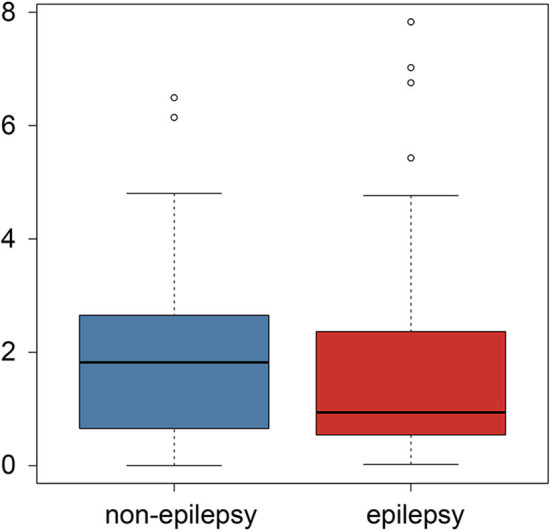
Boxplot of the postoperative epilepsy risk comparison between the preoperative epilepsy and non-epilepsy patients.